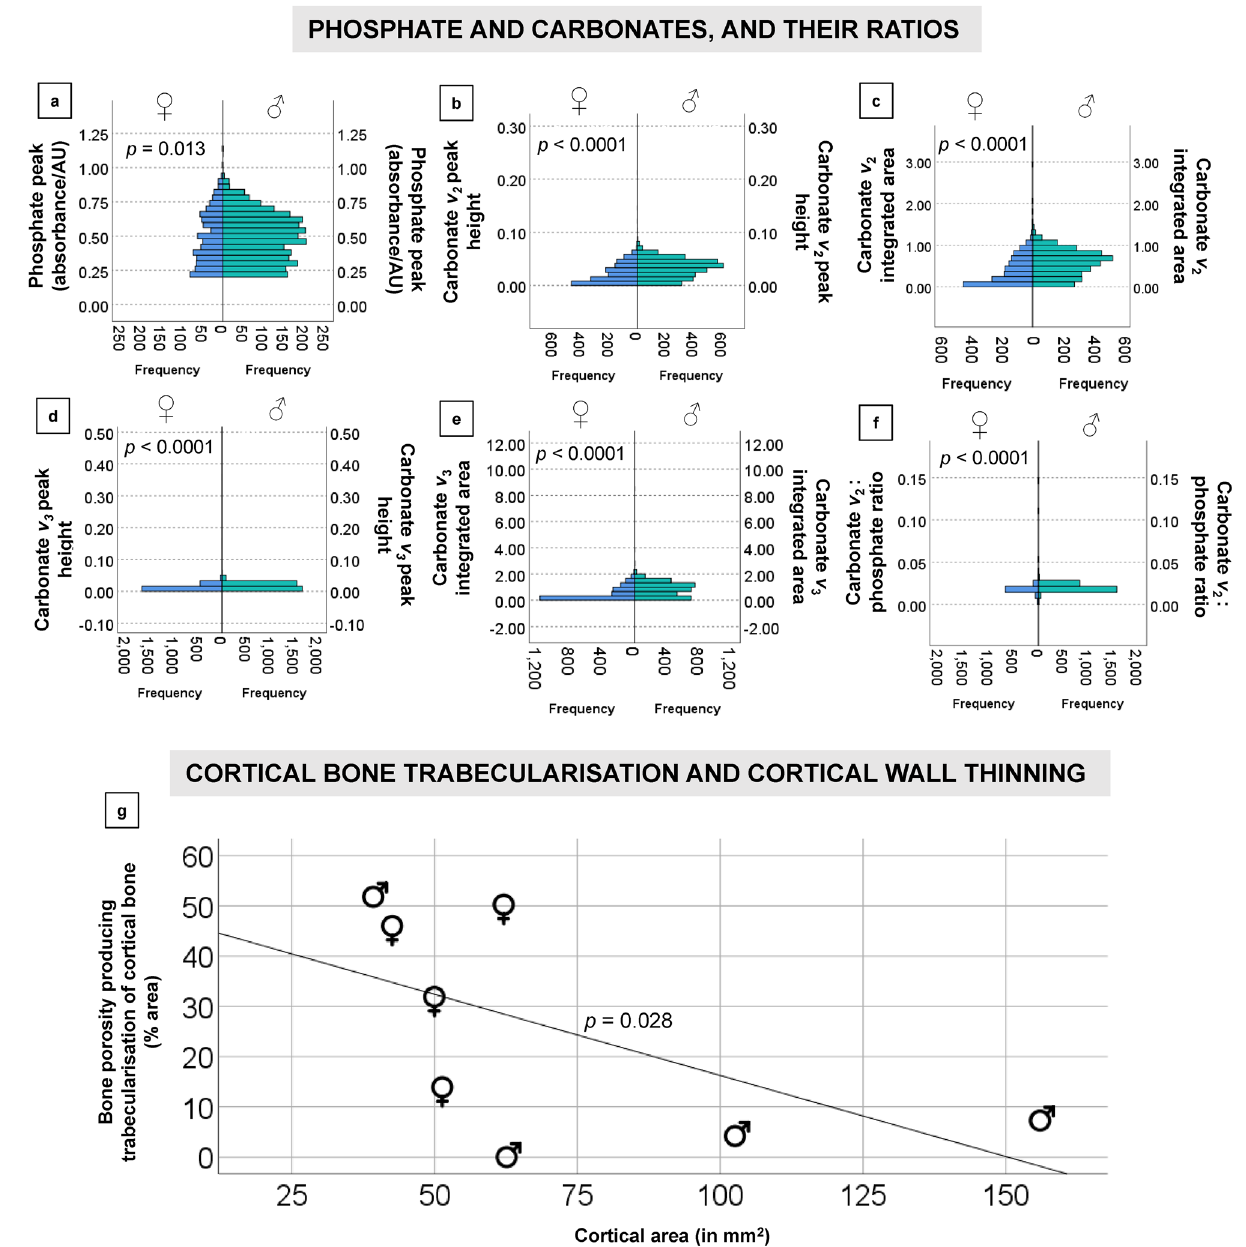
Figure 5. Statistically significant Mann Whitney U ranking comparisons of the sFTIRM data for phosphate peaks ( a ), carbonate peaks and integrated area ( b – e ), and ratios computed using carbonate v 2 : phosphate area ( f ). A strong negative correlation between cortical area and trabecularised cortical bone in the whole sample is shown ( g